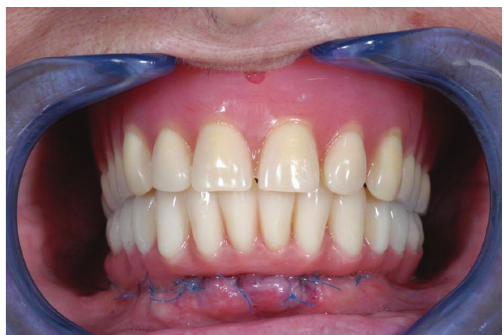
Figure 8: Titanium bar removed from mouth.